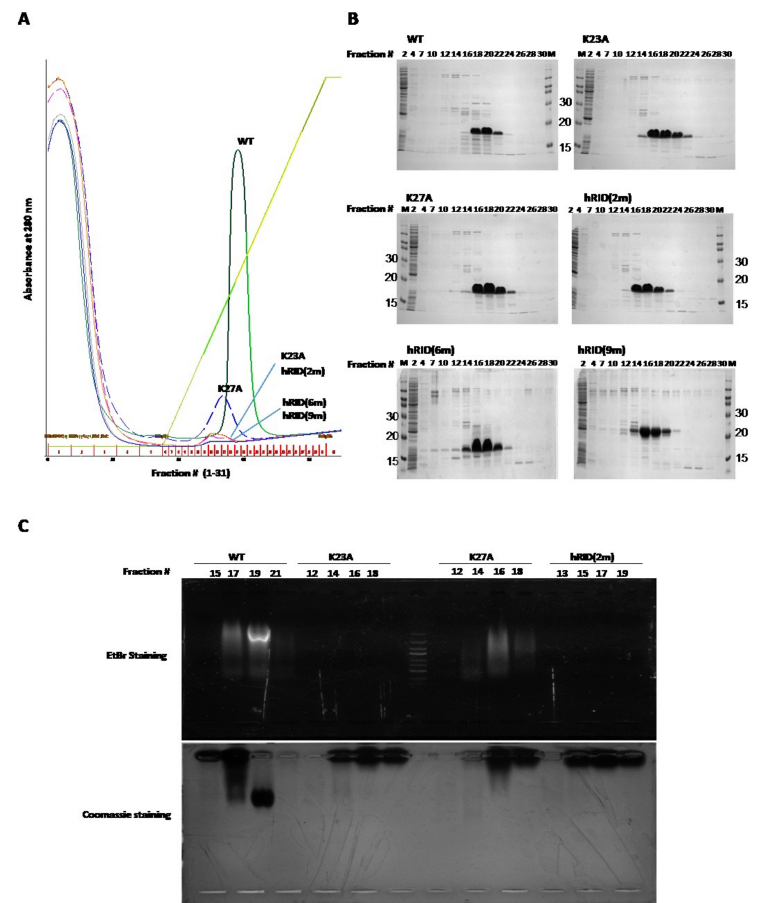
Figure 2. Purification of WT and mutant hRID and detection of them and the co-purified